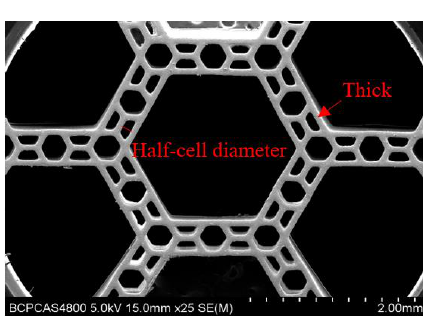
Figure 1. ( a ) Single-level hierarchical honeycomb (SHH), ( b ) multi-level hierarchical honeycomb (MHH).